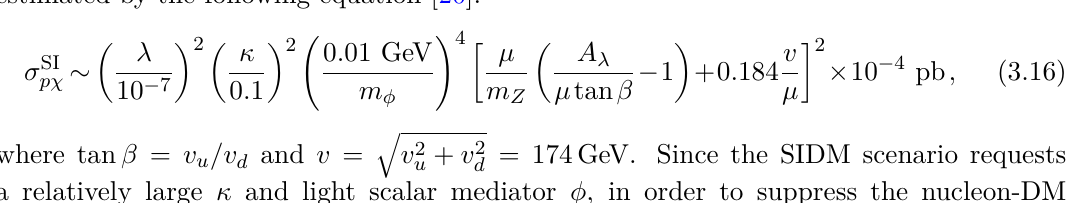
However, the green line crosses the blue regions when m means in this case, the small scale structure and the DM relic density can be addressed simultaneously. By fixing the value of m